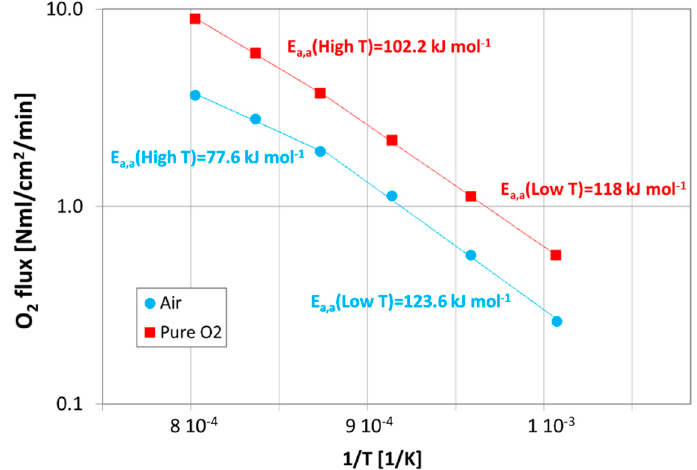
Figure 10. Results in terms of oxygen flux as a function of the inverse of the temperature, collected on the sample M2, both in the presence of air or pure oxygen as process gas, and He as sweep gas (with a flow rate of 100 Nml/min).